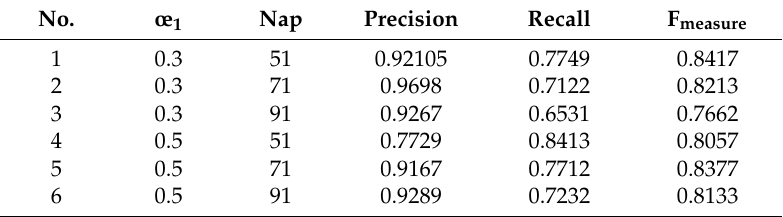
Table 1. The experimental results of the improved algorithm with the Geolife dataset.